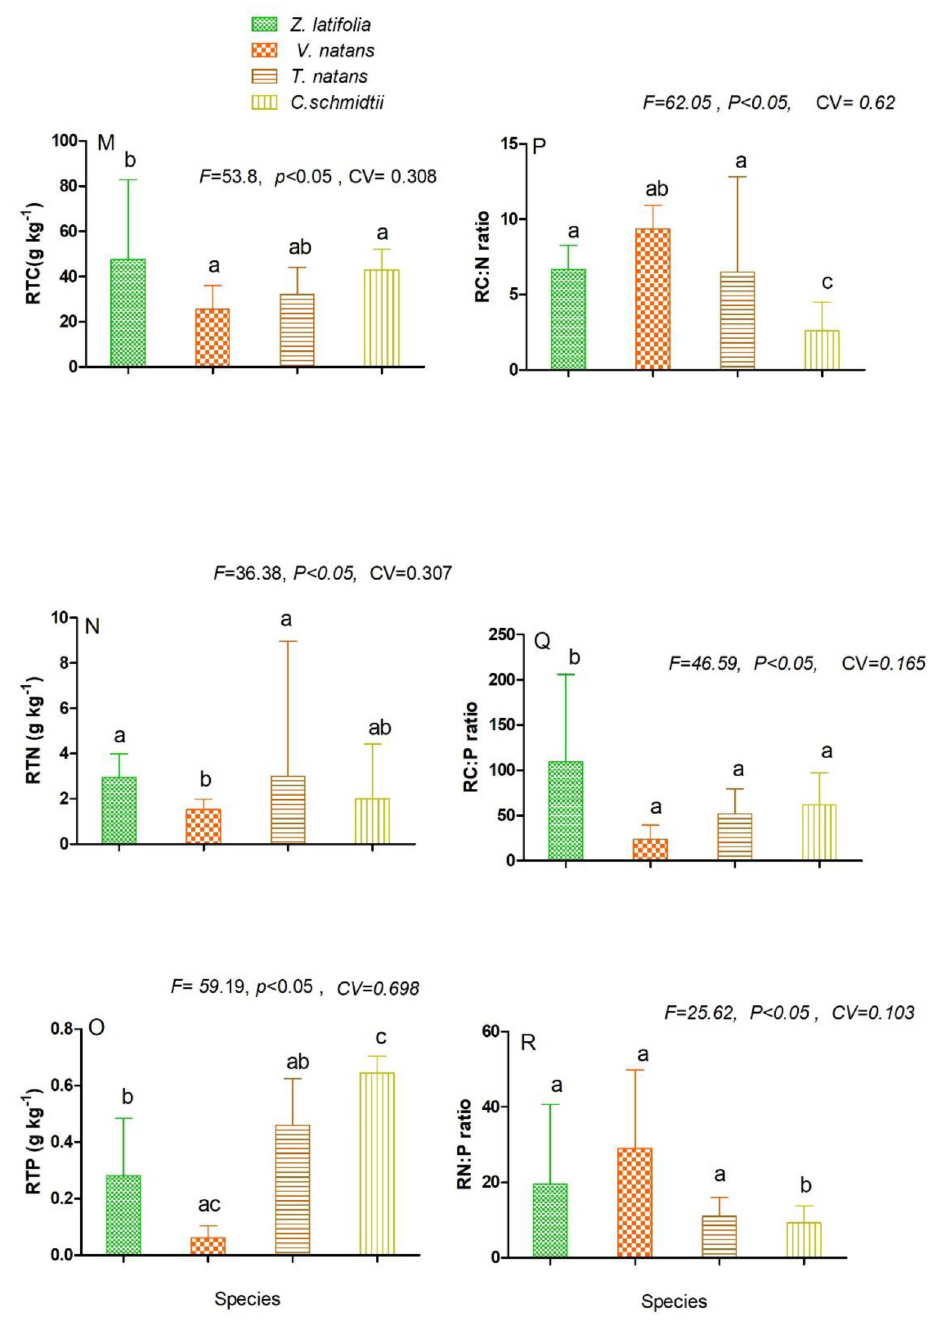
Fig 4. Ecological stoichiometric characteristics of roots C, N, P and their mass ratio among the four studied macrophytes species. RTC-root total carbon-(4M), RTN-root total nitrogen-(4N), RTP-root total phosphorus-(4O), RC: N- root carbon to nitrogen ratio-(4P), RC: P- root carbon to phosphorus ratio-(4Q), RN: P- root nitrogen to phosphorus ratio—(4R). Figures represent Mean ± SD, different letters show significant difference at p < 0.05.